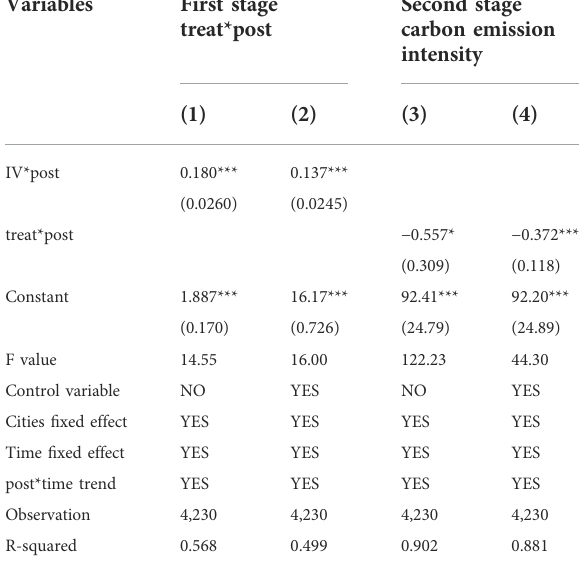
TABLE 7 Endogeneity test: Instrumental variables